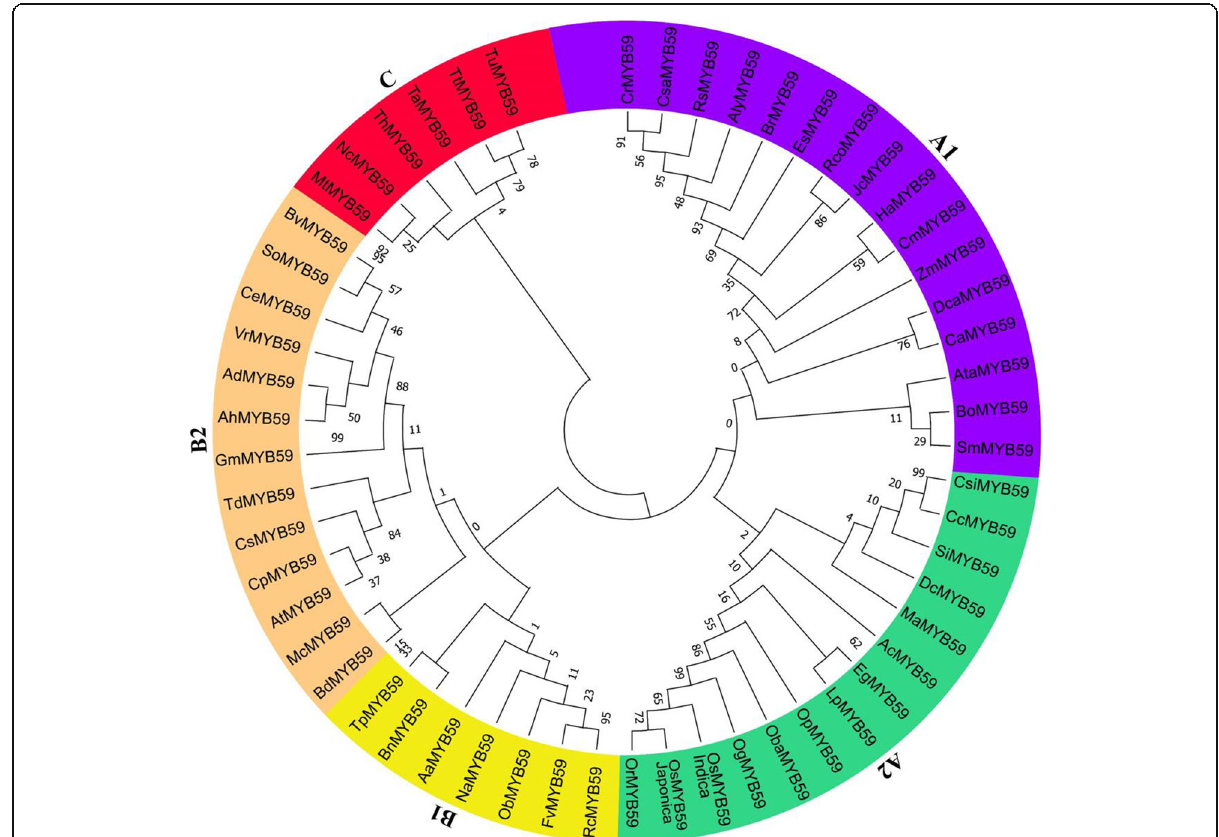
Fig. 1 Phylogenetic relationships among MYB59 proteins from 56 plant species with bootstrap values